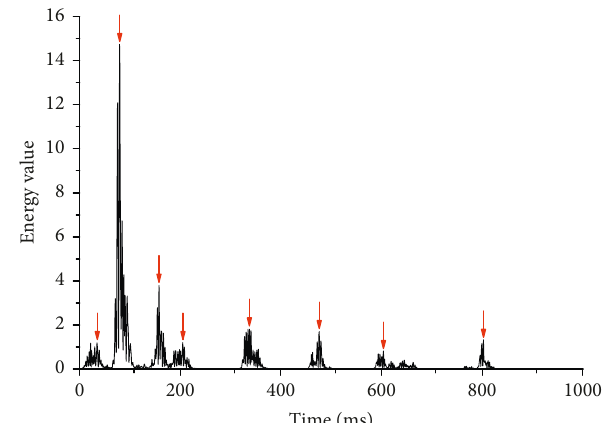
Figure 19: The time-energy distribution of the blasting after